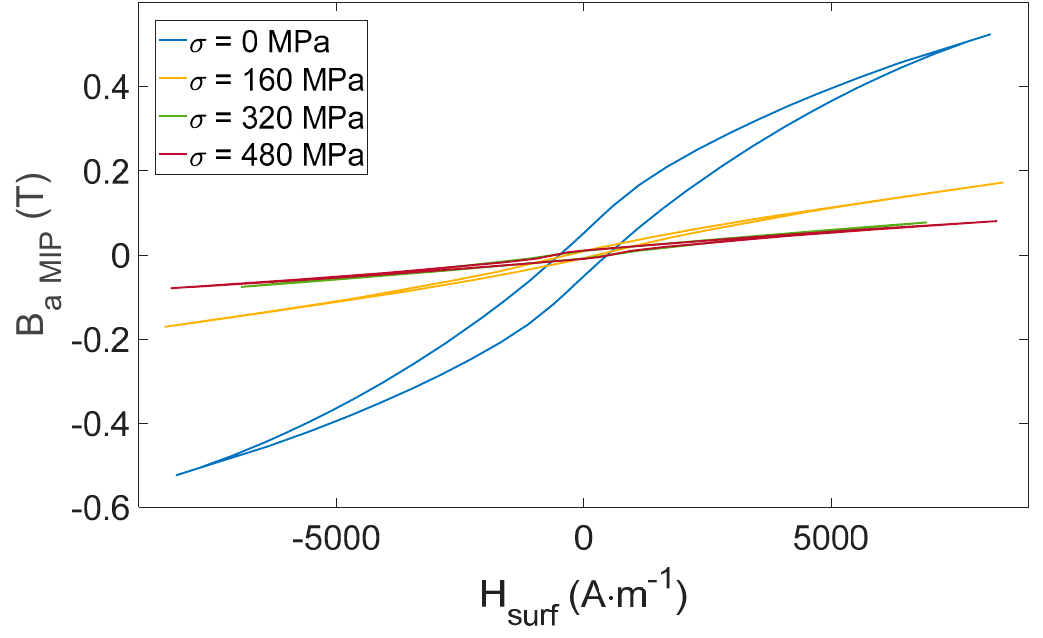
Figure 12. B a MIP ( H surf ) hysteresis cycles for all Figure 9 tests.